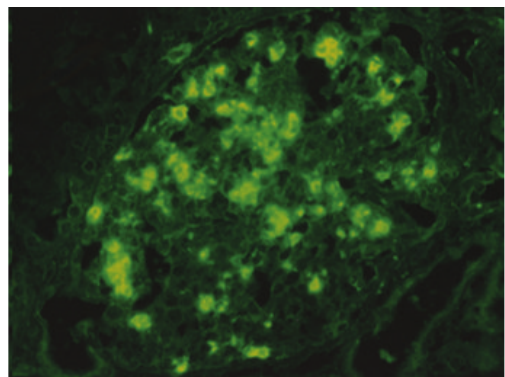
Figure 2: Immunofluorescence staining for NAPlr in tissue sample from a patient with acute poststreptococcal glomerulonephritis. Staining sites, which are thought to represent free antigen, are local- ized primarily in the mesangium and part of the glomerular base- ment membrane (GBM), and infiltrating leukocytes show a ring- like granular pattern (original magnification ×